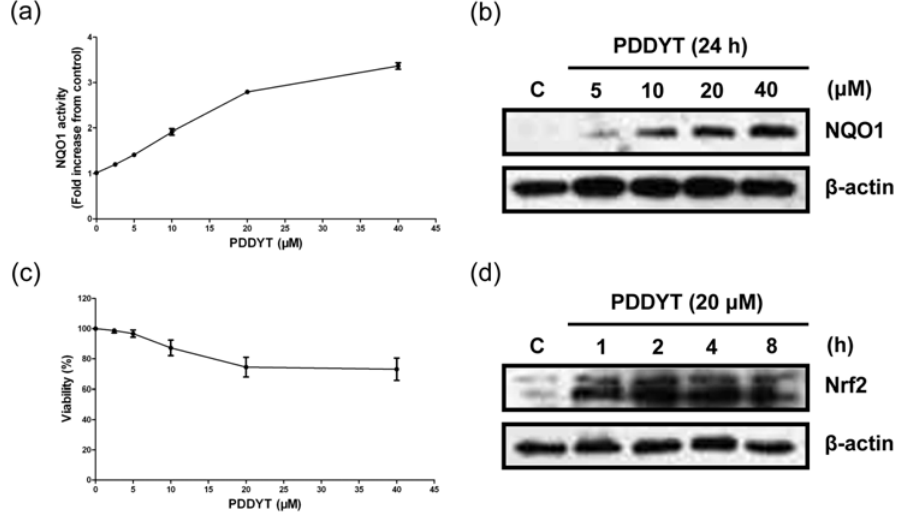
Figure 2. Induction of NQO1 by PDDYT. (a) NQO1 induction assay after Hepa 1c1c7 cells were treated with indicated concentrations of PDDYT for 24 h. (b) Hepa 1c1c7 cells were treated with indicated concentrations of PDDYT for 24 h and analyzed by western blot using anti-NQO1antibody. (c) Crystal violet assay after Hepa 1c1c7 cells were treated with indicated concentrations of PDDYT for 24 h. (d) Nrf2 levels in Hepa 1c1c7 cells were examined after treatment with 20 μ M PDDYT for indicated incubation times.